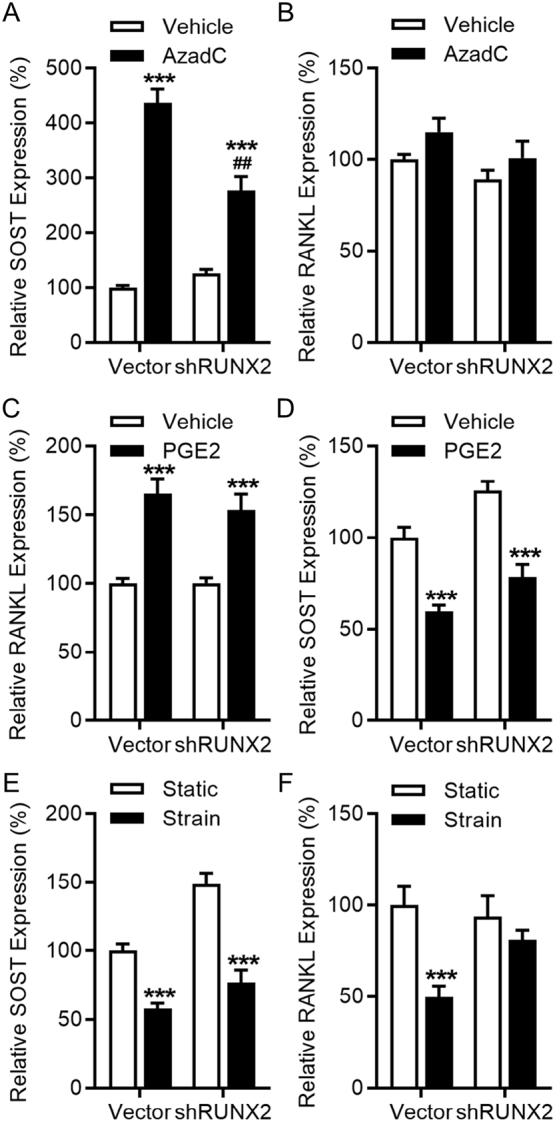
Strain-mediated suppression of SOST proceeds independently of RUNX2. RUNX2 influences basal SOST expression but not regulation of SOST by strain, whereas strain-related RANKL down-regulation but not basal expression are influenced by RUNX2. Cells were treated with 1 μM AzadC for 3 days and assessed for SOST (A) and RANKL (B) expression by RT-qPCR analysis (n = 10). Vector control or shRUNX2 cells were treated with vehicle or 0.5 μM PGE2 and harvested 24 h later to assess for RANKL (C) and SOST (D) expression by RT-qPCR analysis (n = 10). Cells were subjected to strain and harvested 8 h later to assess for SOST (E) and RANKL (F) expression by RT-qPCR analysis (n = 15). Bars represent the mean ± SEM. ** p < .01, *** p < .001 versus static controls of the same cell type, ### p < .001 versus AzadC-treated pWTS1 cells.